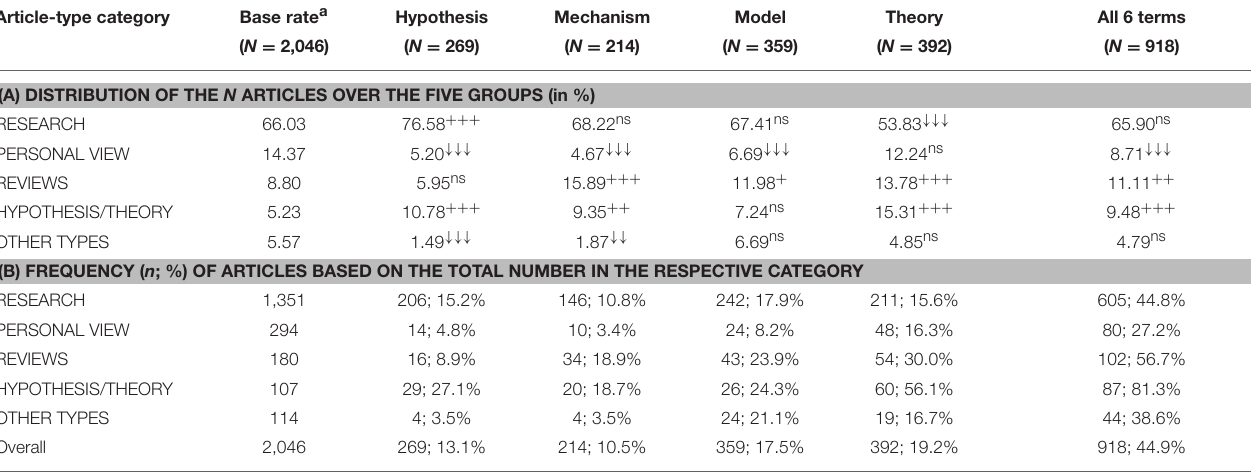
TABLE 4 | Distribution of all articles (base rate) and of five subsets of articles referring to different theory-related terms over five categories of article types. Article-type